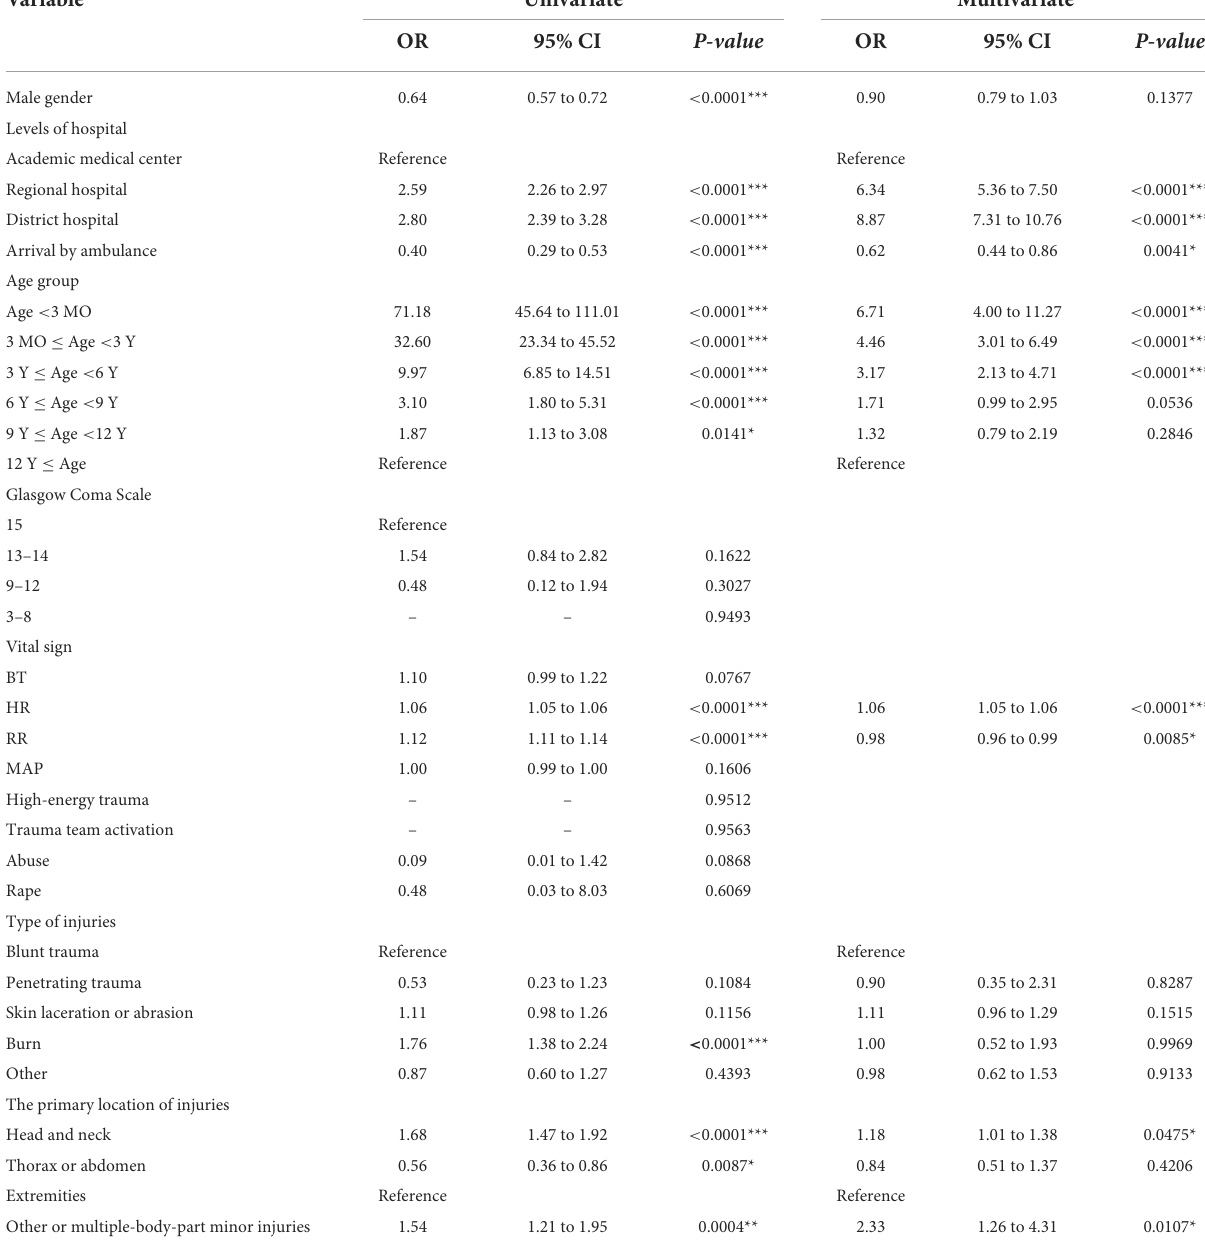
TABLE 3 Univariate and multivariable logistic regression model of associated factors affecting modification ( n = 45,364). Variable